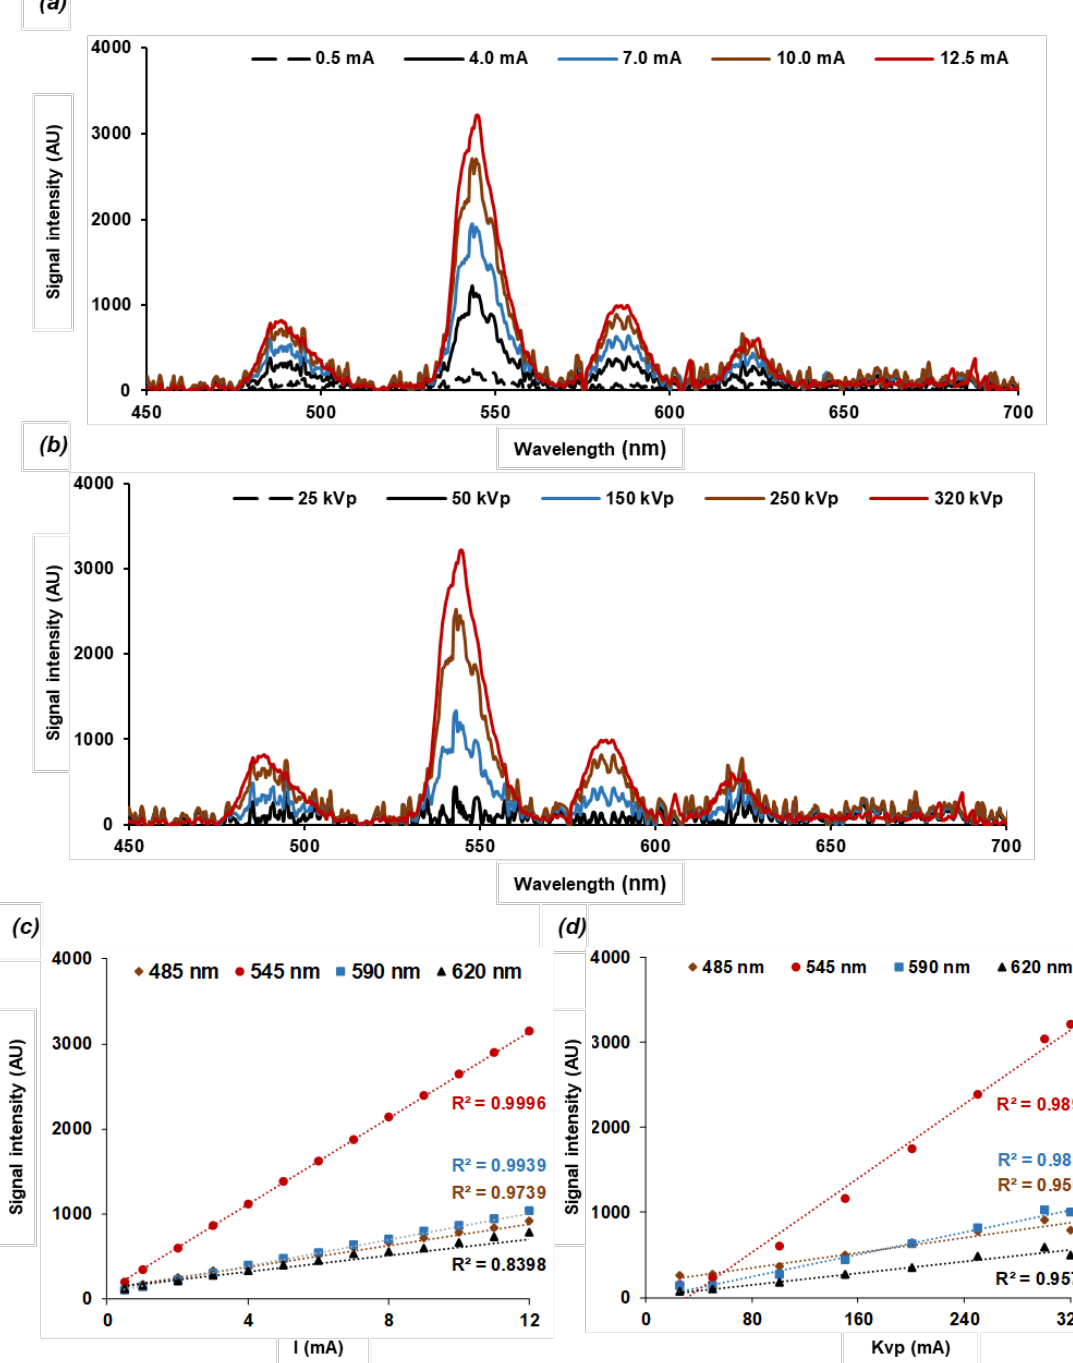
Figure 2. Tb scintillation response as a function of X ray parameters. ( a ) Tb 3+ cation solution was irradiated by increasing tube intensity (mA) with a constant voltage set at 320 kVp. Tb 3+ emission spectra were monitored in the range of 450 to 700 nm. The signal obtained (in arbitrary unit, AU) were plotted for each P1 Q band as a function of tube intensity ( c ). Similarly, the cation solution was irradiated by increasing tube voltages (kVp) with a tube current set at 12.5 mA (photons energy). ( b ) Luminescence signals were plotted for each P1 Q band as a function of tube voltage ( d ). In both cases, Tb luminescence was enhanced for each P1 Q band whatever tube intensity or voltage applied; the main increase variations were obtained for 545 nm P1 Q